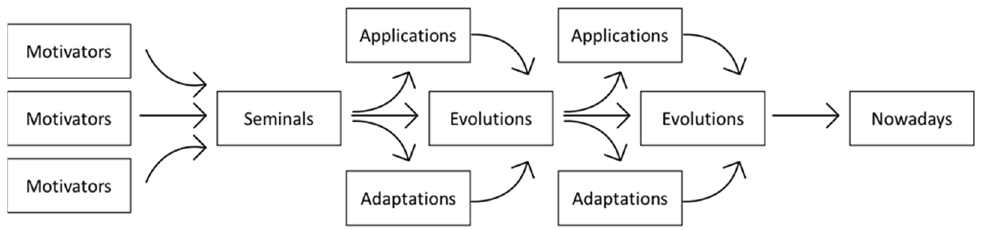
Figure 2. Literature Search Process. Source: prepared by the authors, 2022. As inclusion and exclusion criteria, we used the abstract reading process, seeking the objective of the article, the method, and its main conclusions. The articles in which the focus was not on the application of the model, or on comparing learning models, were discarded.